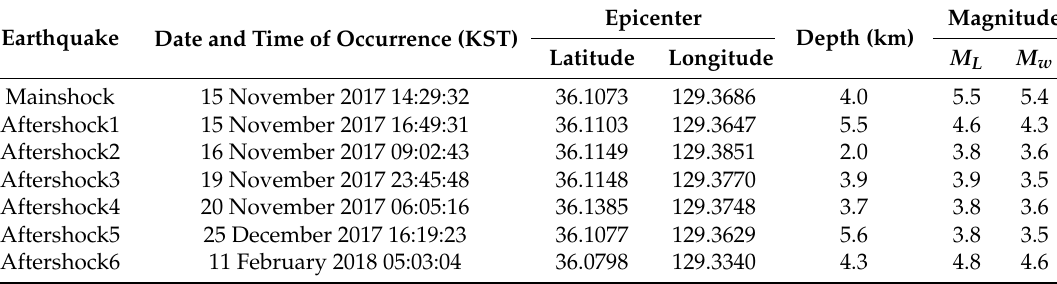
Table 1. Major events of the 2017 Pohang earthquake [1].